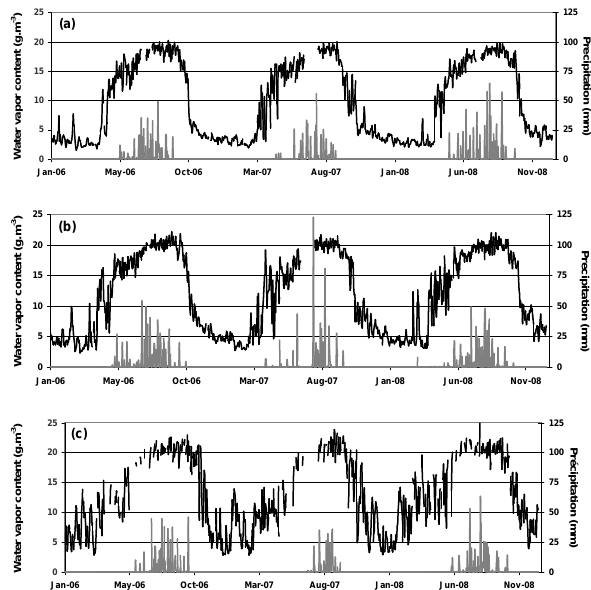
Fig. 4. Daily mean (black circle) and median (open circle) concen- trations and 30-days sliding average on the daily mean (grey line) in Banizoumbou (a) , Cinzana (b) and M’Bour (d) from January 2006 to December 2008.